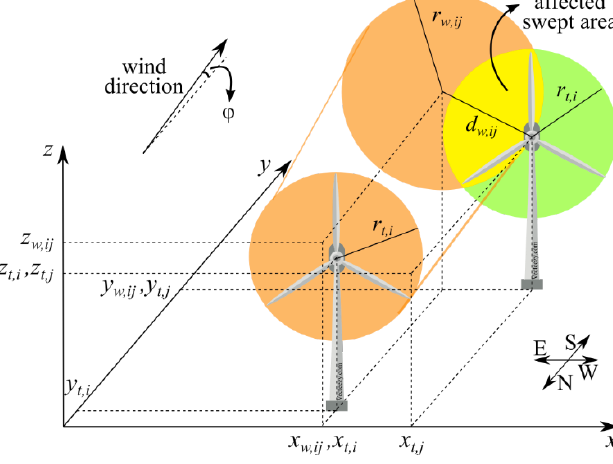
Figure 7. Wake effect of wind turbine 𝑖 on turbine 𝑗 . Figure 7. Wake e ff ect of wind turbine i on turbine j